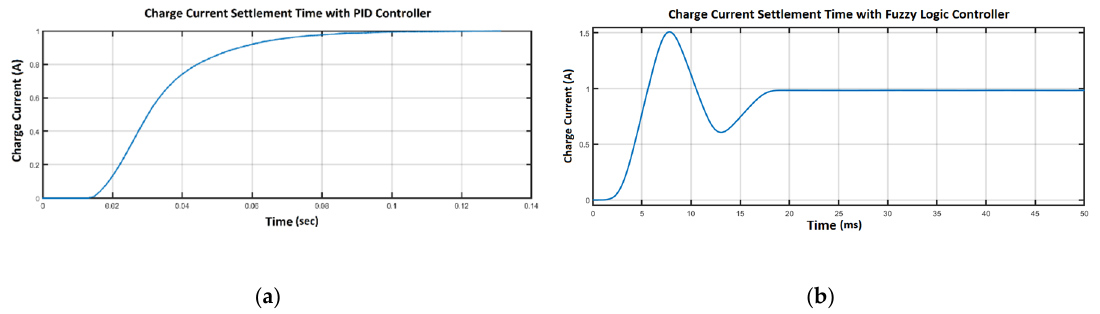
Figure 12. Charge current settlement using ( a ) PID controller ( b ) FLC.